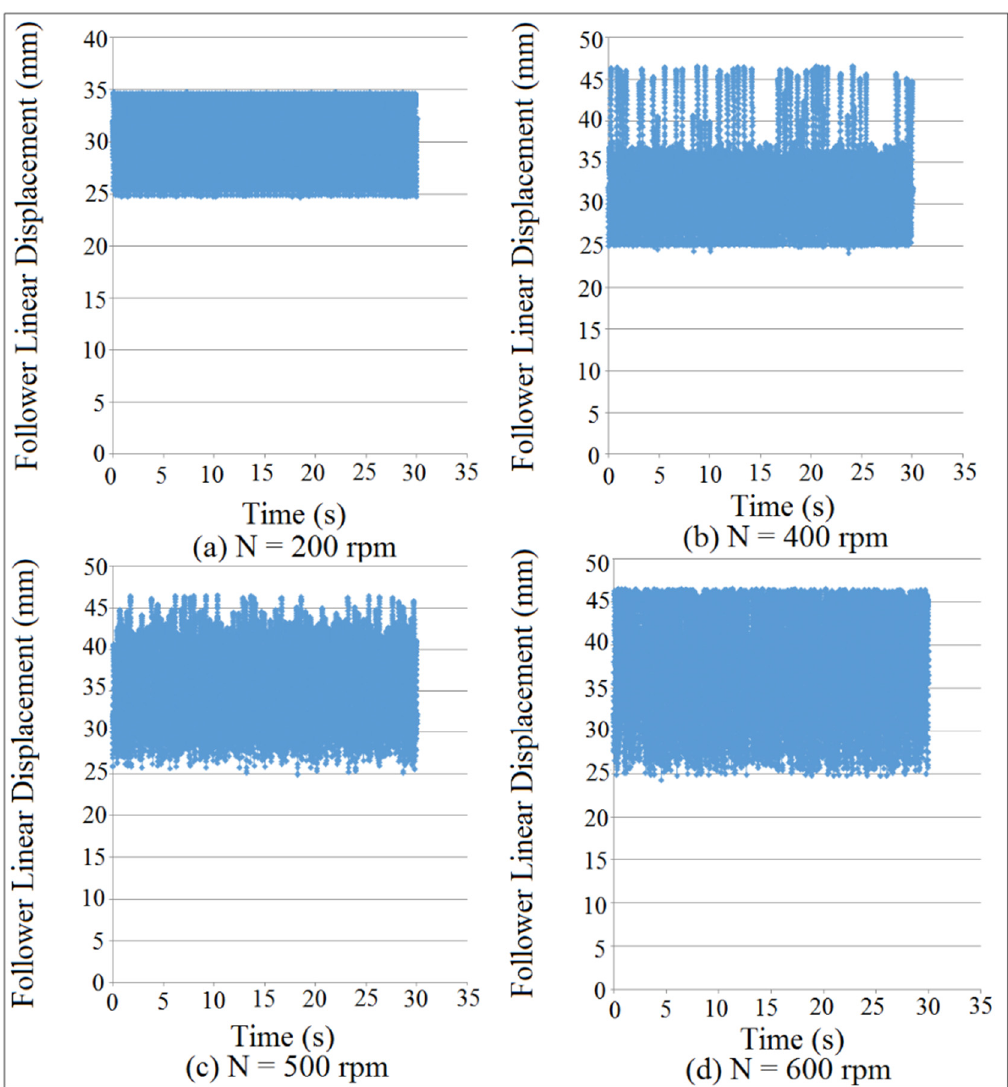
Figure 30. Follower linear displacement mapping against time for (I.D. = 19 mm).